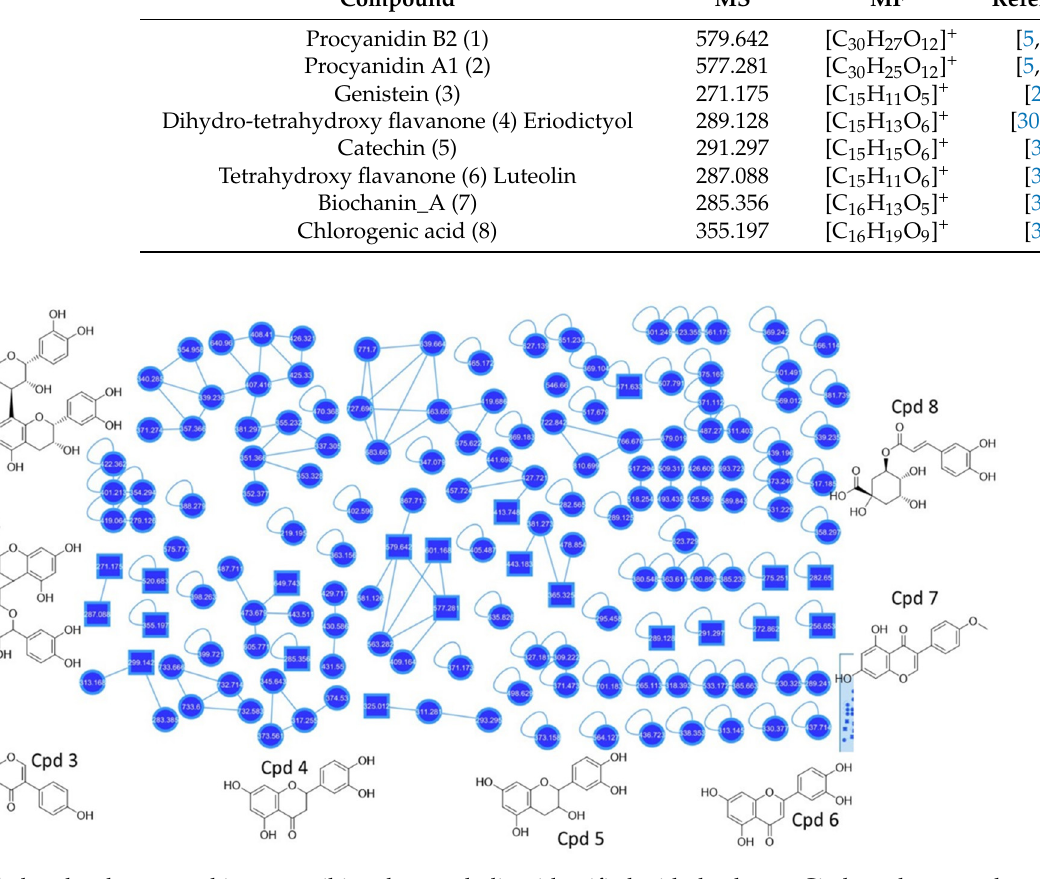
Figure 1. Global molecular networking prescribing the metabolites identified with databases. Circle nodes are unknown, and square nodes are identified metabolites. Table 2. Identified metabolites from the F. sycomorus methanol extract.